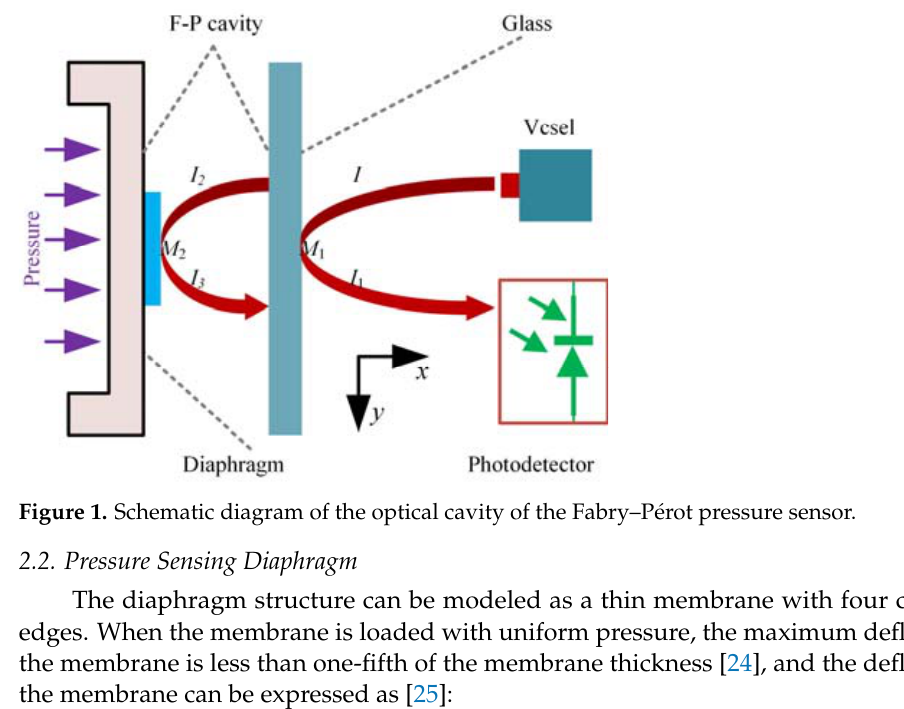
where 2 a is the side length of the membrane, P is the loaded pressure, and D is the flexural rigidity, which can be expressed as: